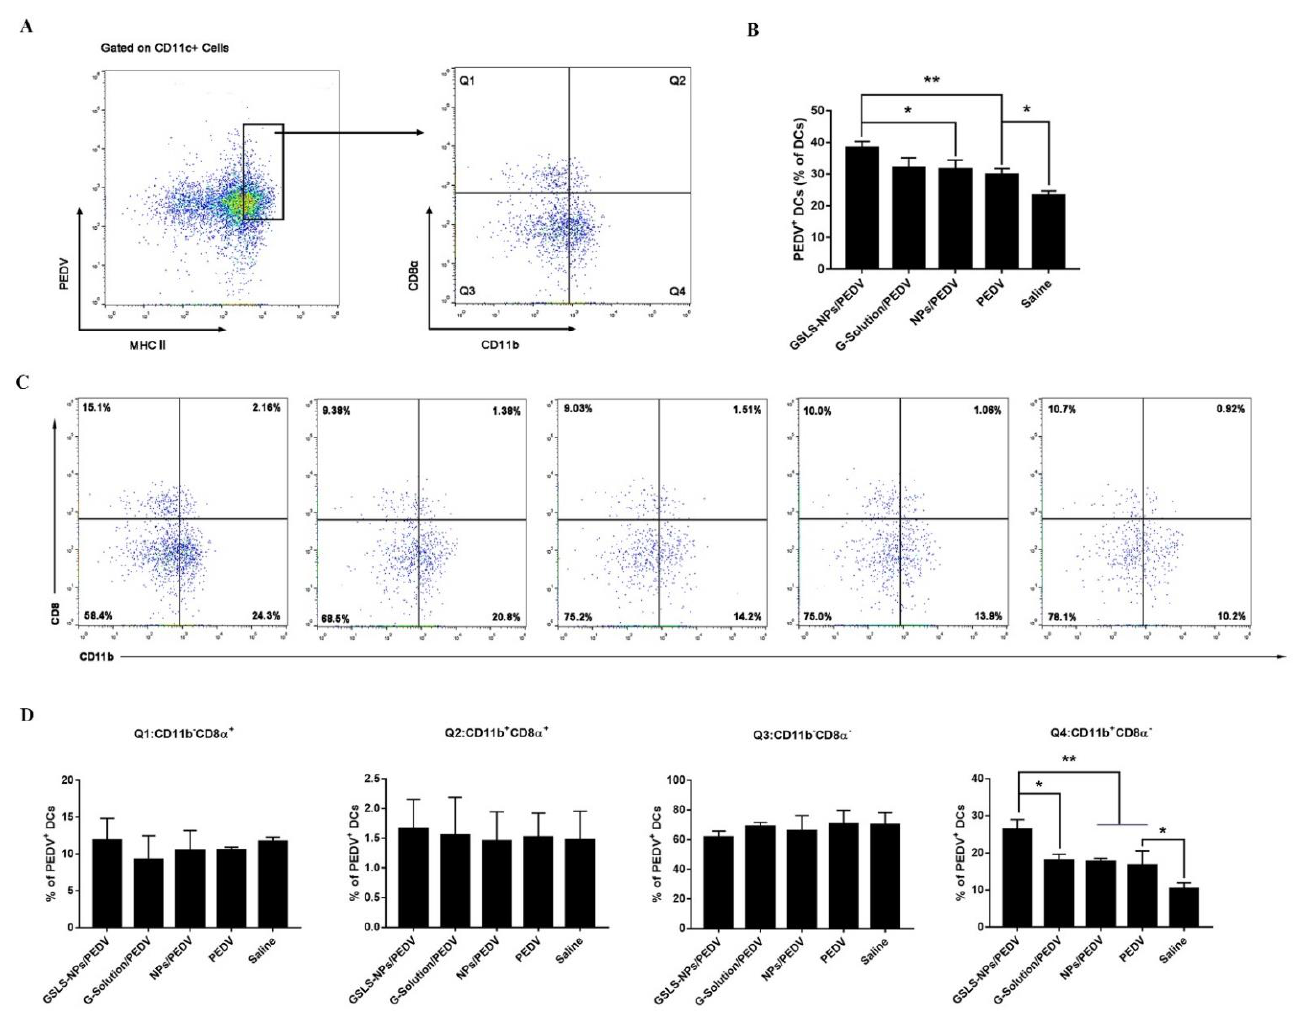
Figure 5. Responses of dendritic cell subsets in the spleen. Mice (n = 6) were gavaged and immunized as described above, and splenocytes were collected after euthanasia on day 23. ( A , B ) Frequency of PEDV-positive DCs. ( C ) Representative dot plot of the DC subset distribution. ( D ) Frequencies of PEDV-positive DC subsets. Data are expressed as the mean ± SD. * p < 0.05, ** p < 0.01. Unpaired Student’s t test.